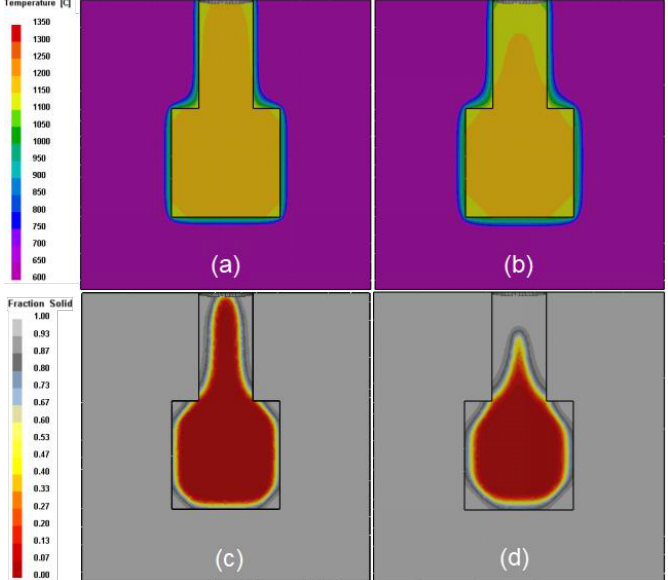
Figure 4. Solidification progress and riser top state of prototype A2 poured at 1300 °C: ( a ) The casting temperature decreased and the riser top dropped slightly; ( b ) Casting temperature continued to decrease; ( c ) Solid fraction distribution when the riser top solidified; ( d ) Mushy zone in casting was isolated outside.